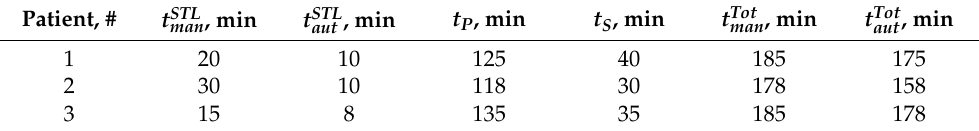
Table 4. Time evaluation for the reproduction and printing of the 3D aneurysm models.